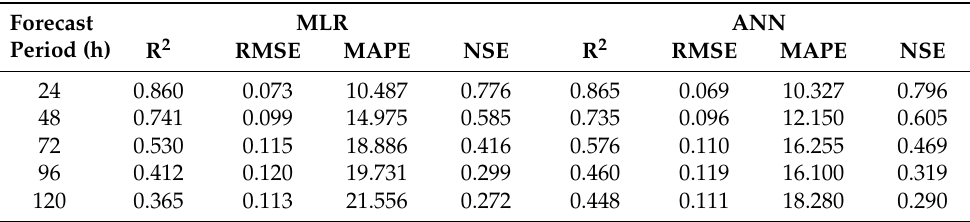
Table 2. The performance evaluation of the single model. Units of the RMSE and the MAPE are gram per litres and percent respectively.